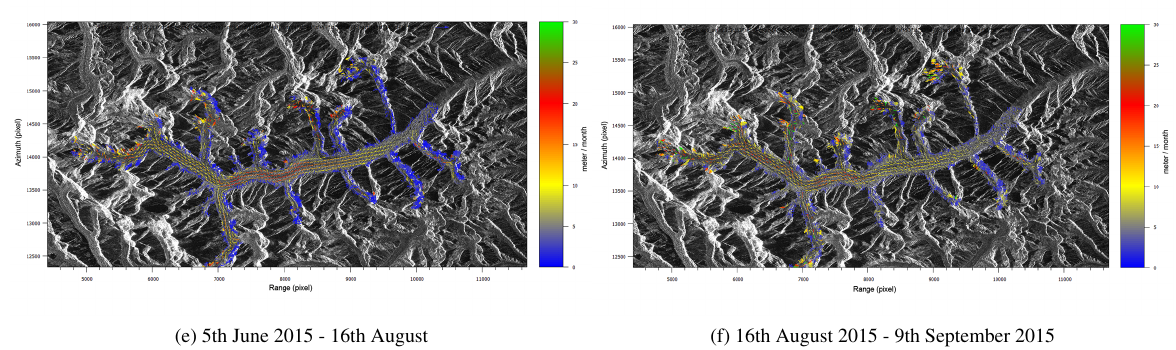
Figure 4: Temporal series of Baltoro Glacier surface velocity field in slant-range